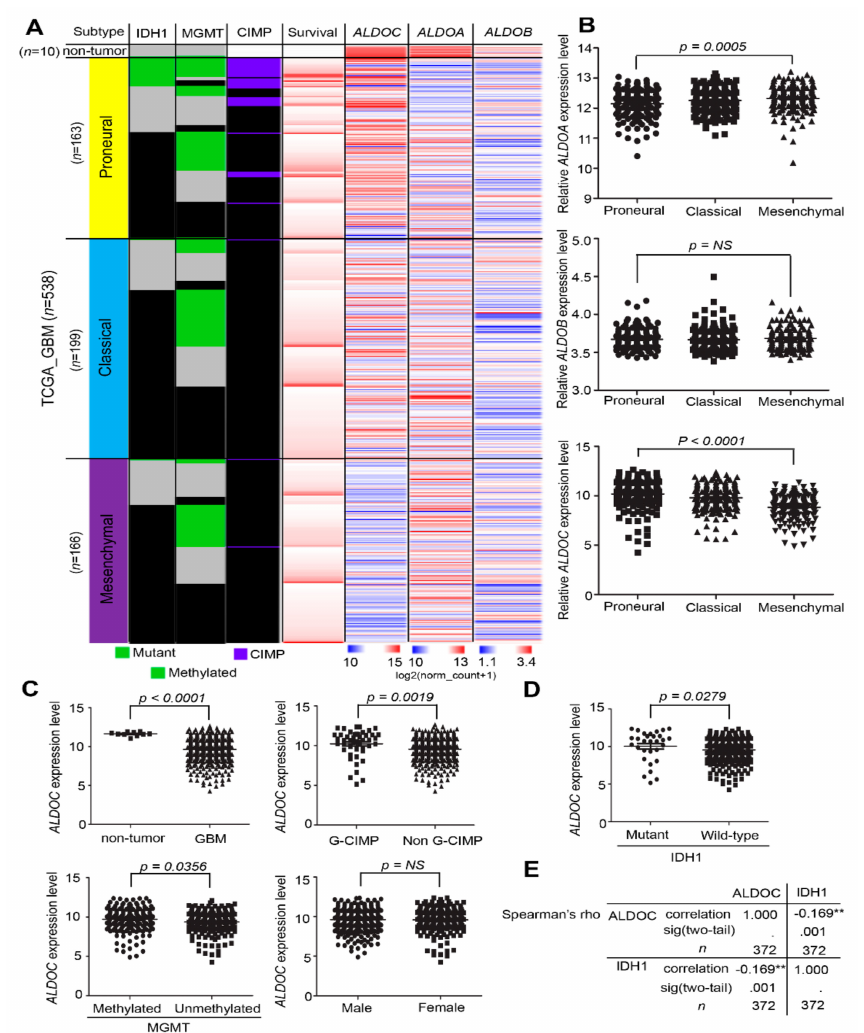
Figure 1. ALDOC mRNA expressed in various subtypes of glioblastomas and correlated with several parameters. ( A ) A heat map showing the endogenous mRNA expression level of the aldolase family members ALDOA, ALDOB, and ALDOC, subtypes, IDH1 mutant status, MGMT methylated status, CIMP status, and survival time in TCGA_Glioblastoma patients ( n = 538). ( B ) A boxplot showing the distribution of each aldolase family member’s expression in clinical patients according to the molecular subtypes in glioblastoma (ALDOA: p = 0.0005, ALDOB: p = non-significant (NS), ALDOC: p < 0.0001). ( C ) A boxplot showing the distribution of ALDOC expression in clinical patients according to histology, CIMP status, MGMT methylated status, and sex in the glioblastomas ( n = 538, p < 0.0001, p = 0.019, p = 0.0356, and p = NS, respectively). ( D ) A boxplot showing the distribution of ALDOC expression in clinical patients according to the IDH1 mutant status in the glioblastomas ( n = 538, p = 0.0279). ( E ) The correlation between the ALDOC mRNA level and the mutation event of IDH1 in glioblastoma patients from the TCGA cohort (spearman’s rho = ~0.169, p = 0.001). The significance of the di ff erences in B was analyzed using the one-way ANOVA formula. The significance of C and D were analyzed using a Student’s t -test. All cut-o ff values were set before analysis, and all tests were two-tailed. (** p <